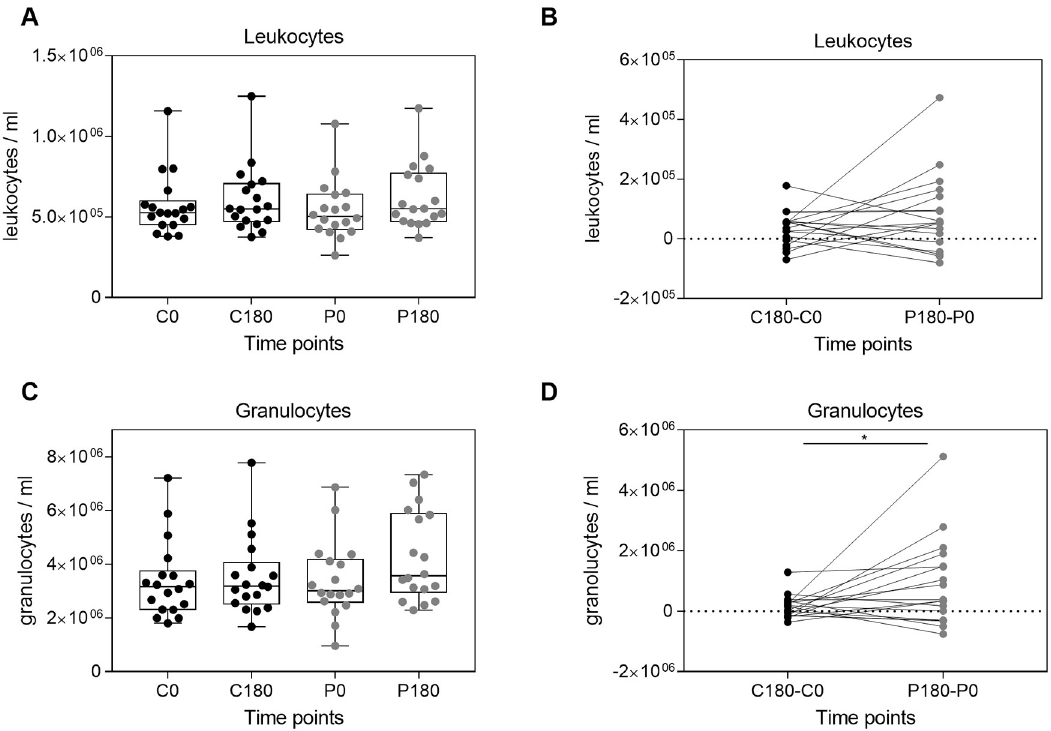
Fig 2. The number of circulating leukocytes remained stable, while granulocytes increased during parabolic maneuvers. Total numbers of indicated cell populations were identified by flow cytometry. Number of leukocytes (A) and granulocytes (C) shown for individual donors from the control period, one day before flight (C0) and three hours later (C180), as wells as during the flight before the parabolic maneuvers started (P0) and immediately after the 31 microgravity phases (P180). The boxes represent the 25th, 50th, and 75th percentile and the whiskers represent the range of the observations. (B) Comparison of the cell kinetics at the control period (C180-C0) with the parabolic flight period (P180-P0) for leukocytes and (D) granulocytes. Each point signifies a single donor. Asterisks indicate p-values ( ��� p < 0.001; �� p < 0.01; � p < 0.05) for statistical